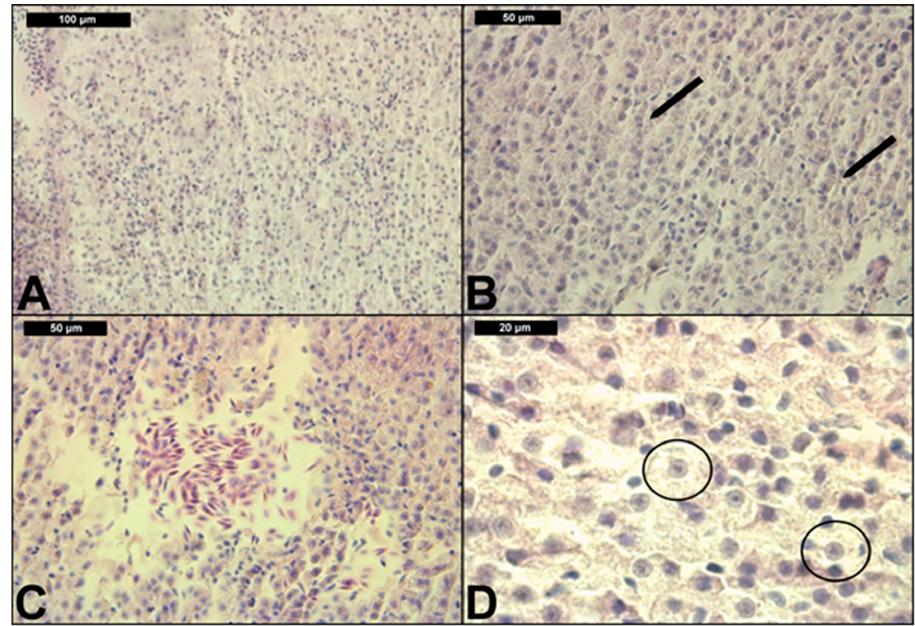
Figure 1. Histopathological alterations in the liver of common carp after the exposure with decreasing CPF concentrations based on Directive 2013/39/EU of the European Parliament and of the Council.